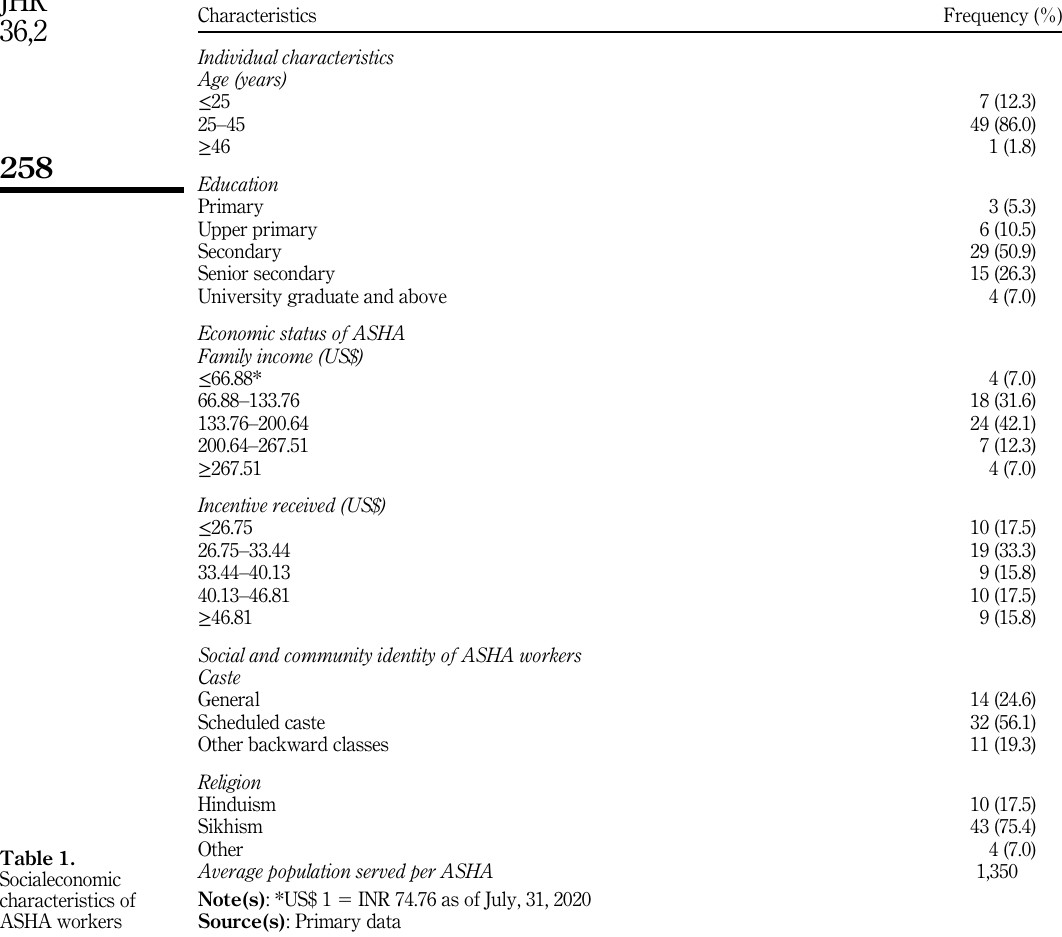
characteristics of ASHA